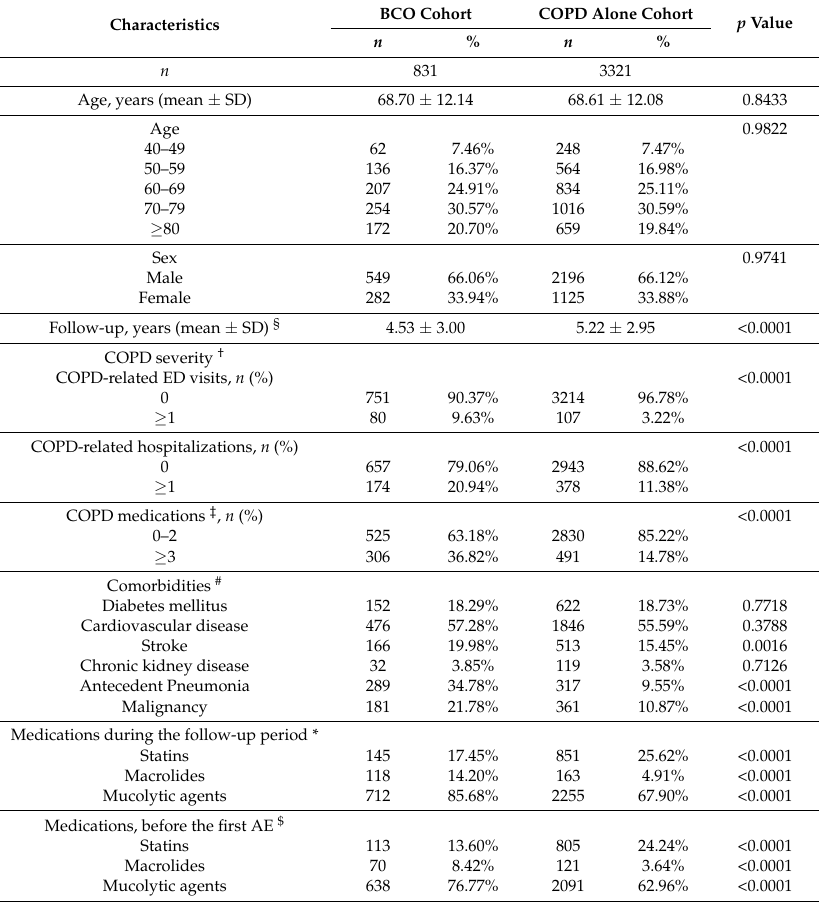
Table 1. Characteristics of the bronchiectasis-COPD overlap (BCO) and COPD alone